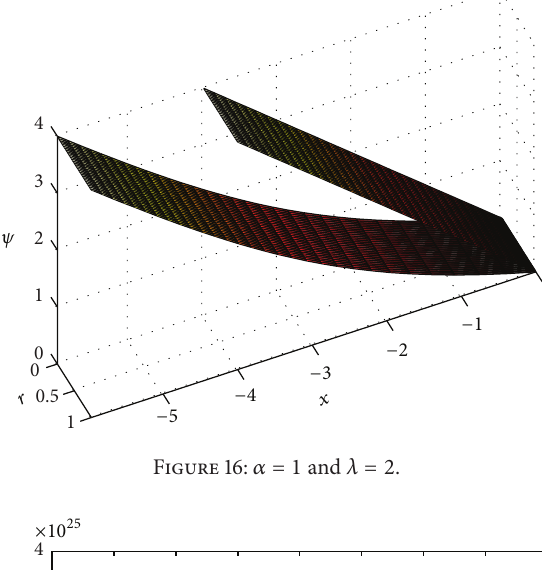
Figure 16: 𝛼 = 1 and 𝜆 = 2 .